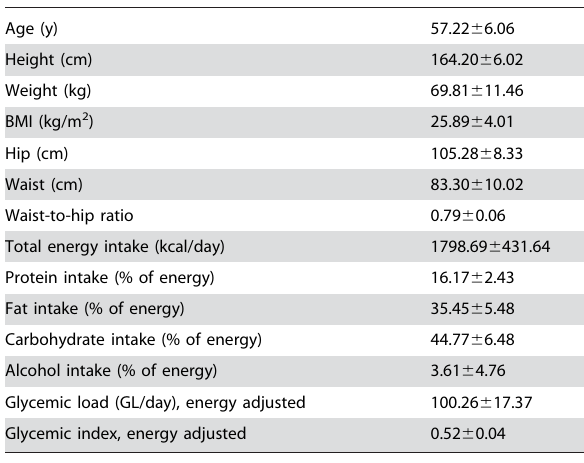
Table 1. Anthropometrical and food intake characteristics of